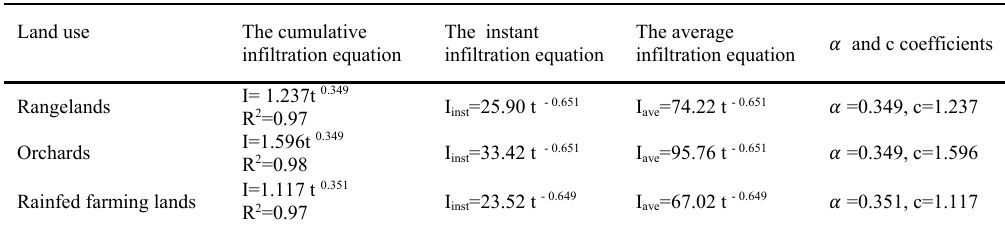
Table 3: Results of the double rings method in different land uses